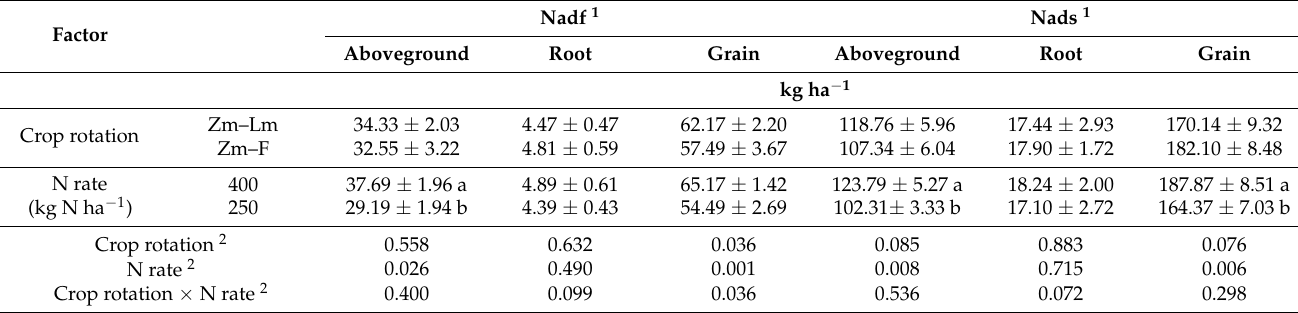
1 Average values of each variable ± standard error. Different letters in the column indicate statistically significant differences between the levels of each factor, based on multiple LSD Fisher comparisons ( α ≤ 0.05). 2 p value (<0.05) corresponds to the effect of the crop rotation and N dose factors and the interaction of the